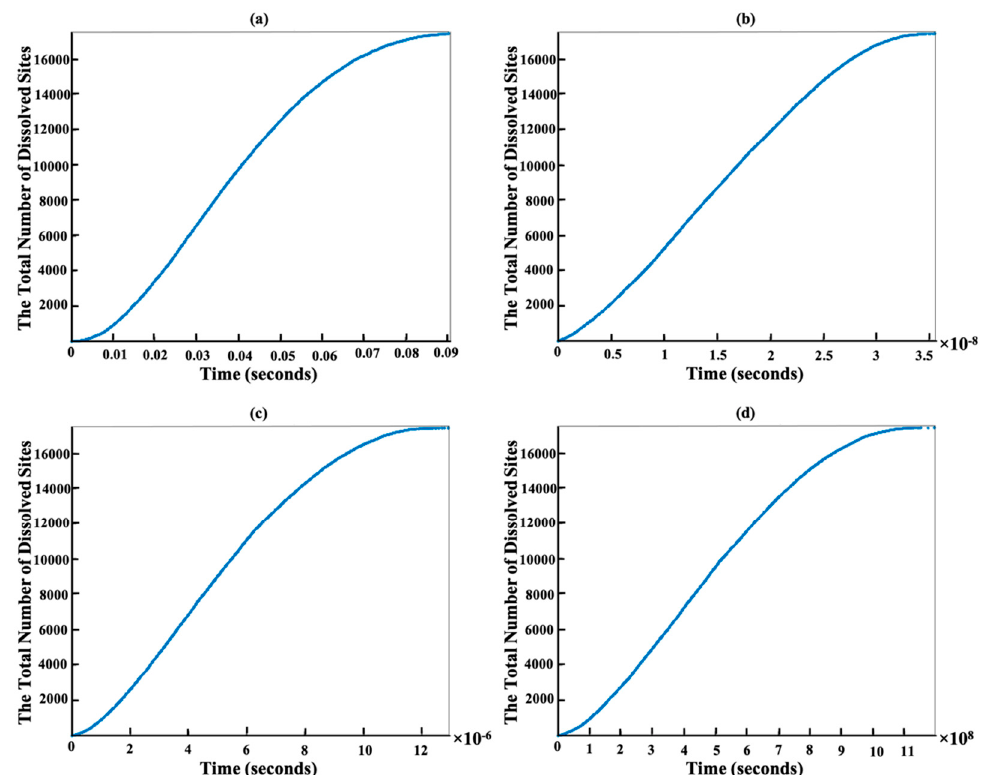
Figure 9. Time evolution of sites dissolution of the whole crystal morphology of portlandite for each facet independent from contribution of other facets. 001 or 001 ( a ), 010 or 010 ( b ), 110 or 110 ( c ), and 100 or 100 ( d ).